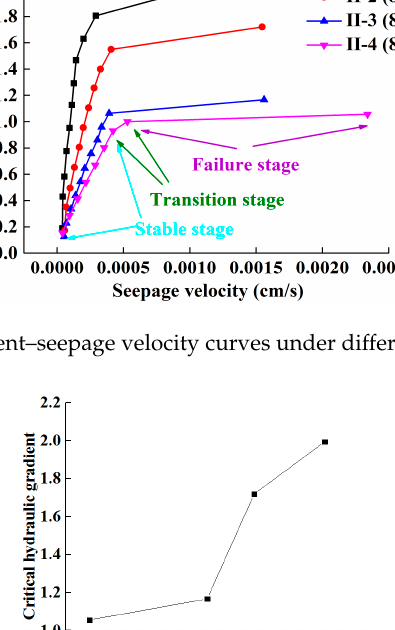
Figure 7. Critical hydraulic gradients for different degrees of compaction.